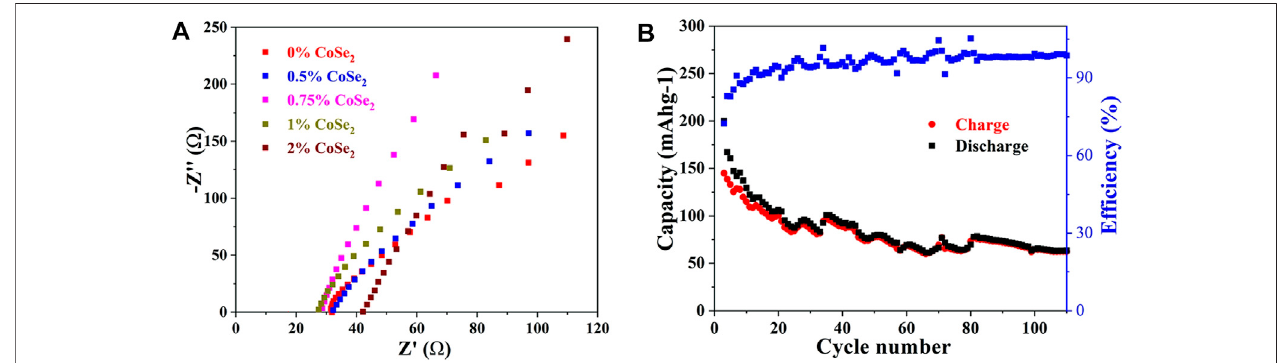
FIGURE 8 | (A) Nyquist plots of CoSe 2 -doped Li 10.35 Si 1.35 P 1.65 S 12 (B) Cycling stability of the all-solid-state lithium battery assembled with 1% CoSe 2 doped